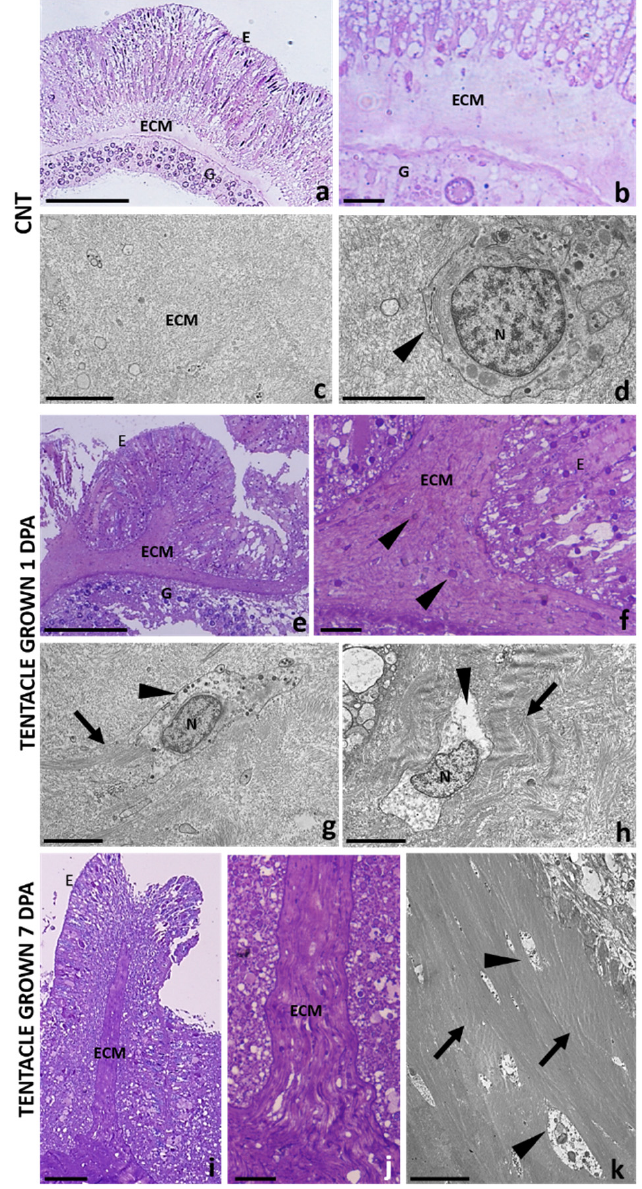
Figure 4. Light and electron transmission microscopy analyses of control and amputated organisms. In the control tentacle ( a – d ), mesoglea ECM, localized between the epidermis and gastrodermis, appears as a loose matrix. Ultrastructural TEM images ( c , d ) show that it is composed of a meshwork of thin filaments in which no fibrillar collagen and only few round shape amebocytes (arrowhead) are detectable. After one day from amputation ( e – h ), epithelial columnar cells of the regrowth tentacle are arranged in a circular way surrounding the inner mesoglea. Elongated amoebocytes (arrowheads) with irregular nuclei ( g , h ) and collagen fibrils (arrows) concentrated on their outer surface are visible. After 7 dpa ( i – k ), the regenerated tentacle increased in length, supported by a robust and extended collagenic scaffold, in which spindle-shaped fibroblast-like cells (arrowheads) have migrated. ECM, Mesoglea; E, Epidermis; G, Gastrodermis; N, nuclei. Scale bars—( a , e ) 100 µm; ( i ) 50 µm; ( b , f , j ) 10 µm; ( c , k ) 5 µm; ( d , g , h ) 2 µm.